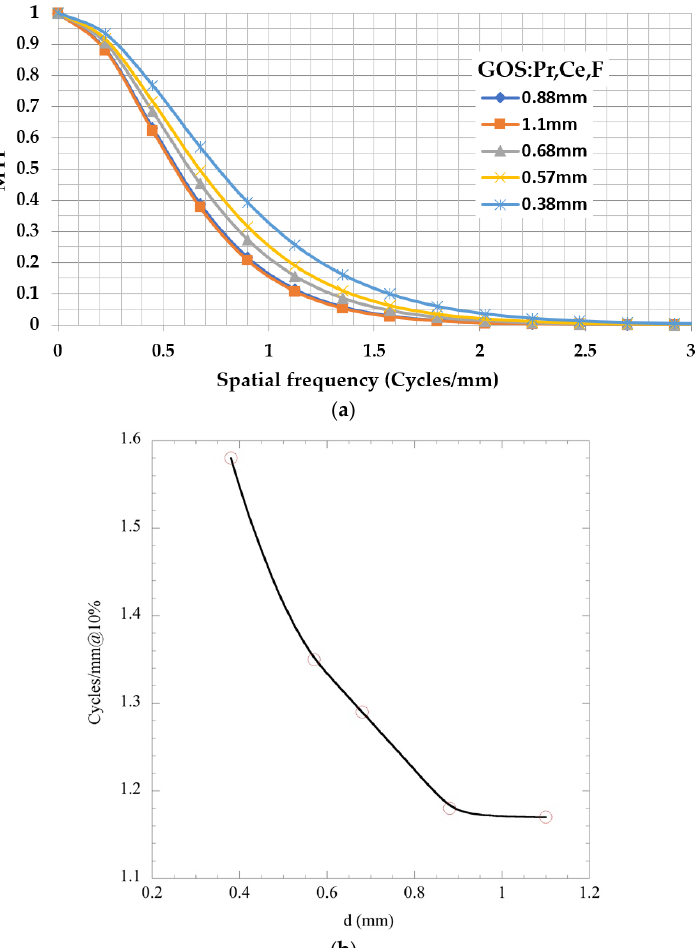
Figure 9. ( a ) Comparison of the MTFs of Gd 2 O 2 S:Pr,Ce,F employed in the Kodak Min-R screens as measured experimentally in transmission mode 1 cycle mm -1 = 1 lp mm −1 . ( b ) cycles/mm@10% of Gd 2 O 2 S:Pr,Ce,F as a function of the screens’ thickness. The solid line in the graphs is a guide for the eyes.